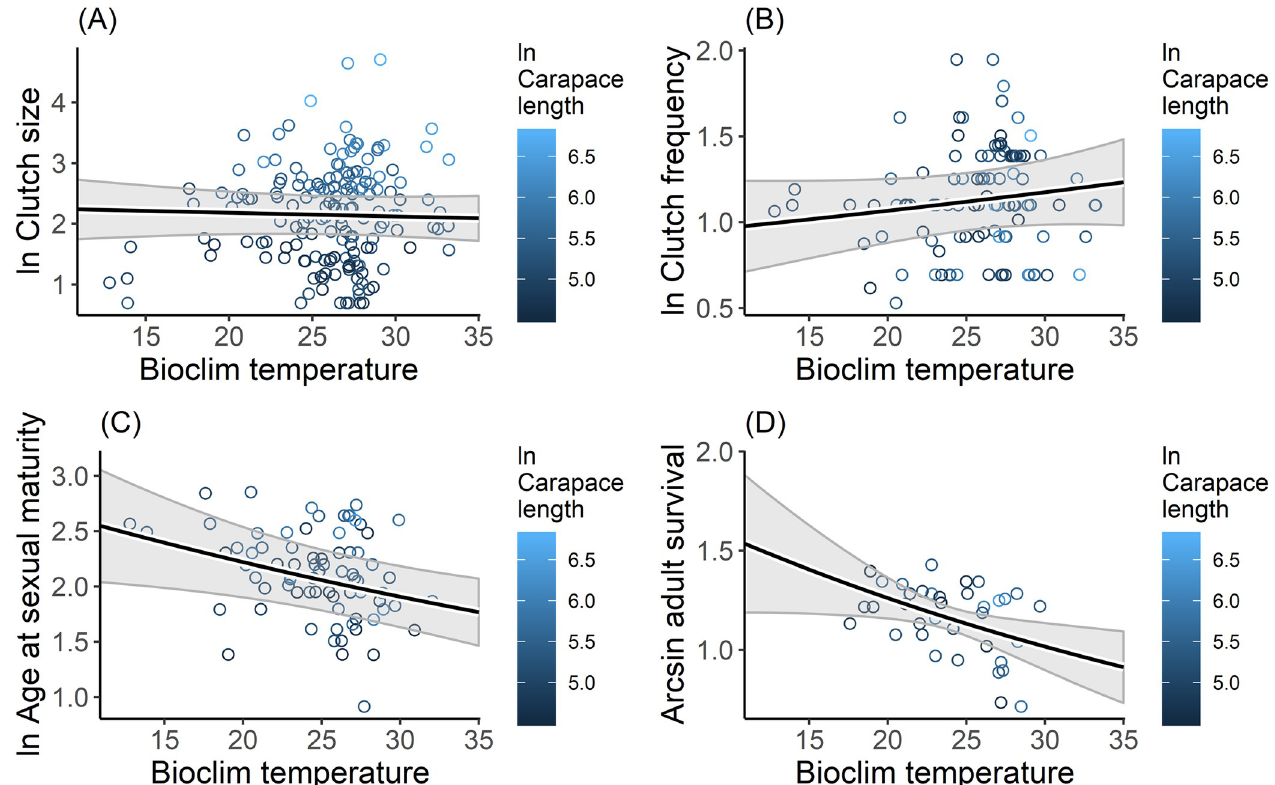
Fig 4. Relationships between bioclimatic temperature (Mean Temperature of Warmest Quarter) and (A) clutch size, (B) clutch frequency, (C) age at sexual maturity, and (D) adult survival rate of freshwater turtles. Points are the median species values obtained from the literature (S1 Table), colored representing ln carapace length values. Solid black line is the GAM prediction. Grey shaded polygons show 95% confidence bands around the prediction.